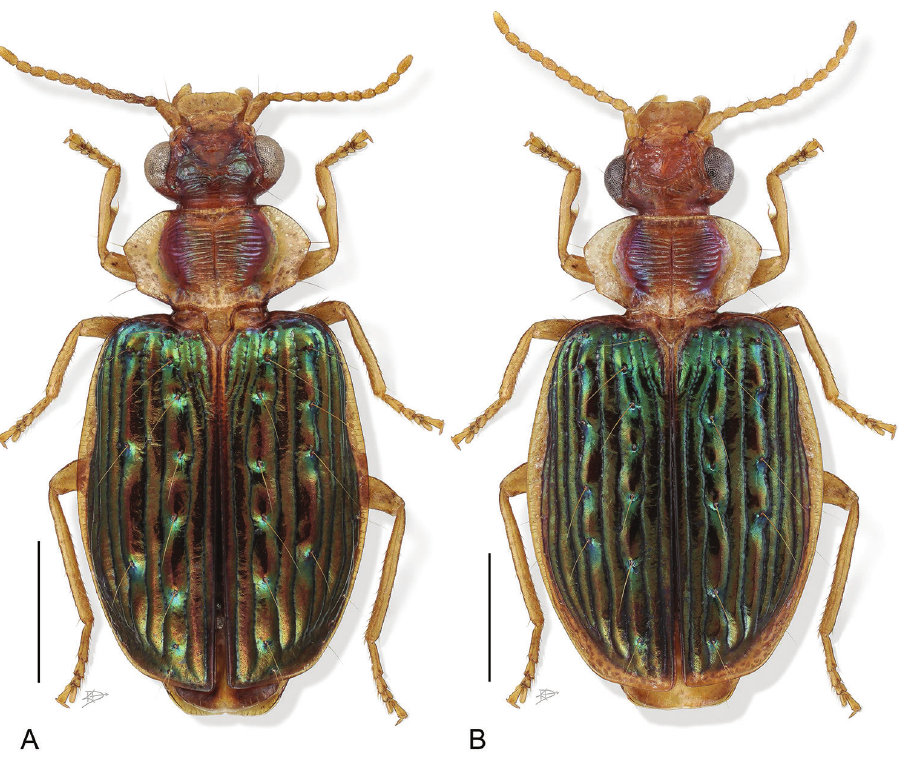
Figure 3. Digital Photo-illustration. Habitus, dorsal aspect. A Hyboptera shasta Erwin, sp. n., male, ADP135875 B Hyboptera tepui Erwin & Henry, sp. n., male,